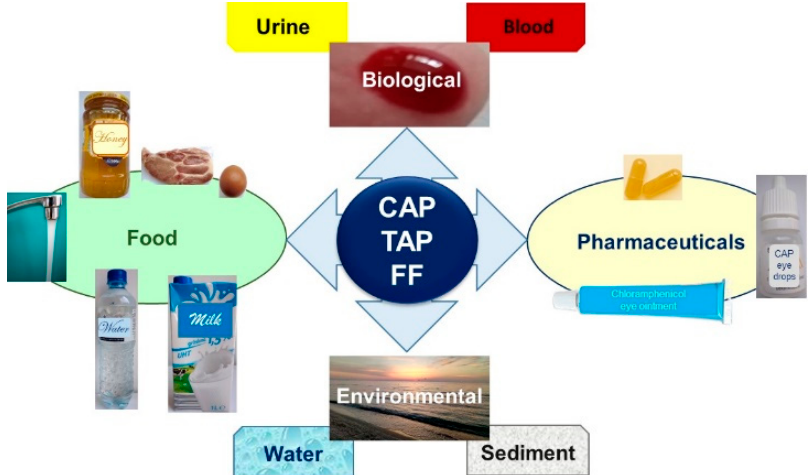
Figure 4. Schematic representation of samples used to test the practical ability of the sensors devel- oped for amphenicol electrochemical analysis. oped for amphenicol electrochemical